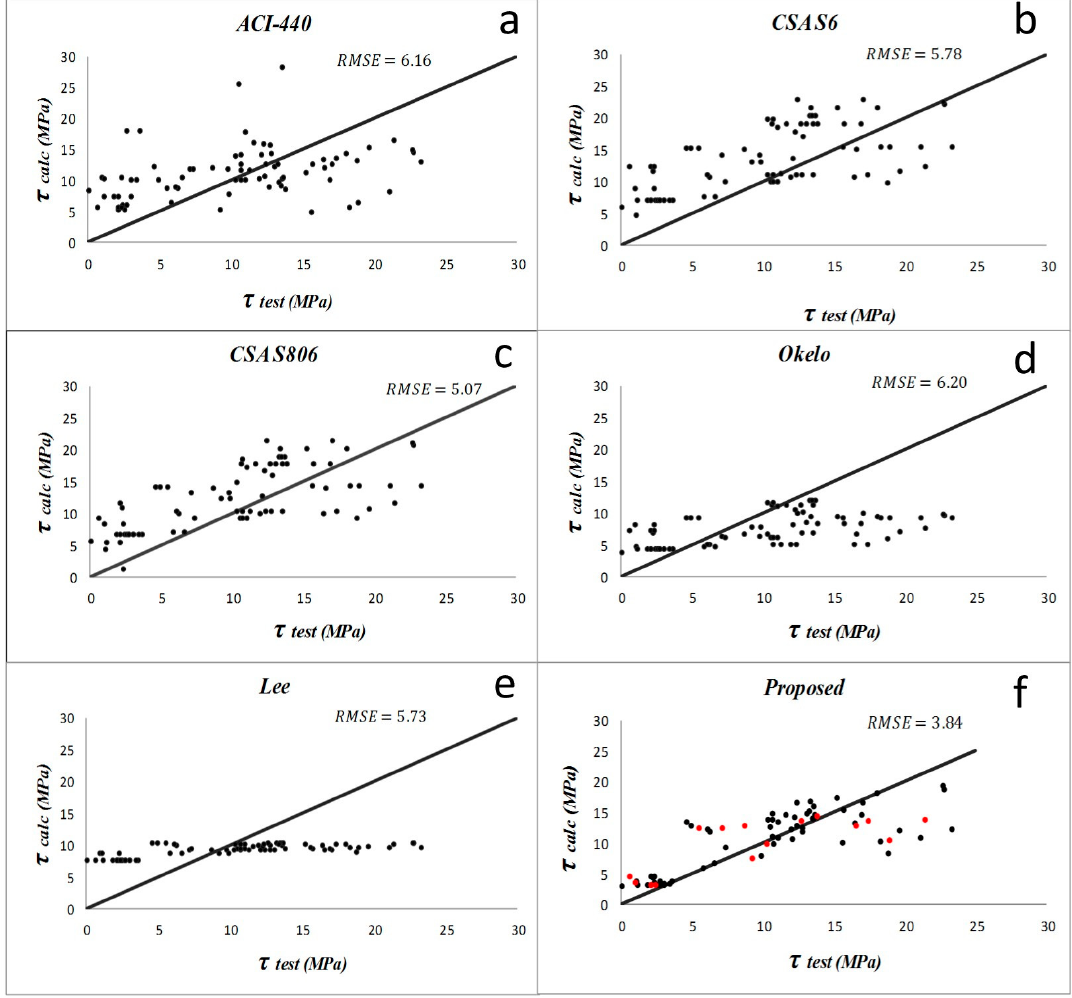
Figure 5. Bond strength prediction results by different models ( a – f ) on the normal concrete with non-sand-coated fiber-reinforced polymer (FRP) bars (study group 1). The data used for validation are shown as red points in figure ( f ).